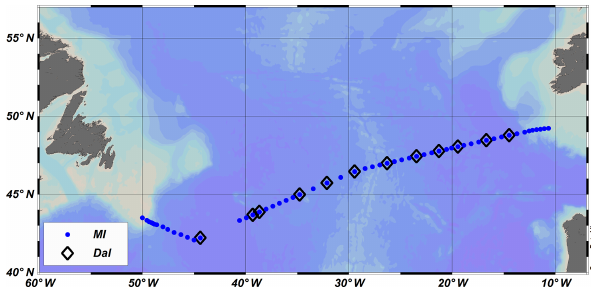
Figure 1. Station positions sampled along the GO-SHIP A02 trans- Atlantic survey completed in May 2017. The Marine Institute (MI) group sampled and analysed nutrient samples at every station along the transect, while the Dalhousie group (Dal) analysed nutrient sam- ples from a selected number of sites, marked with a diamond. Both groups analysed samples over the full water